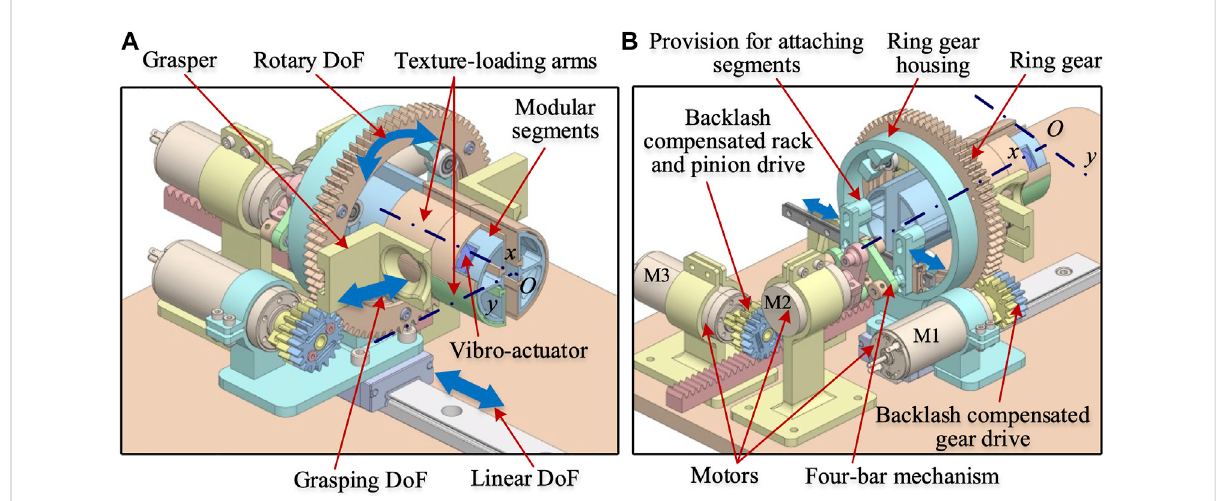
FIGURE 2 CAD model of the proposed haptic grasper (A) Isometric view (partial section of the textural loading arm is hidden to reveal vibro-actuator) (B) Another view of the grasper showing the motors and drive mechanism. The double-headed arrows in each model show the grasper ’ s direction of motion. The modular segments are attached with texture loading arms and vibro-actuators, which are fi xed to a 4-bar mechanism and can only move in a lateral direction providing the grasping